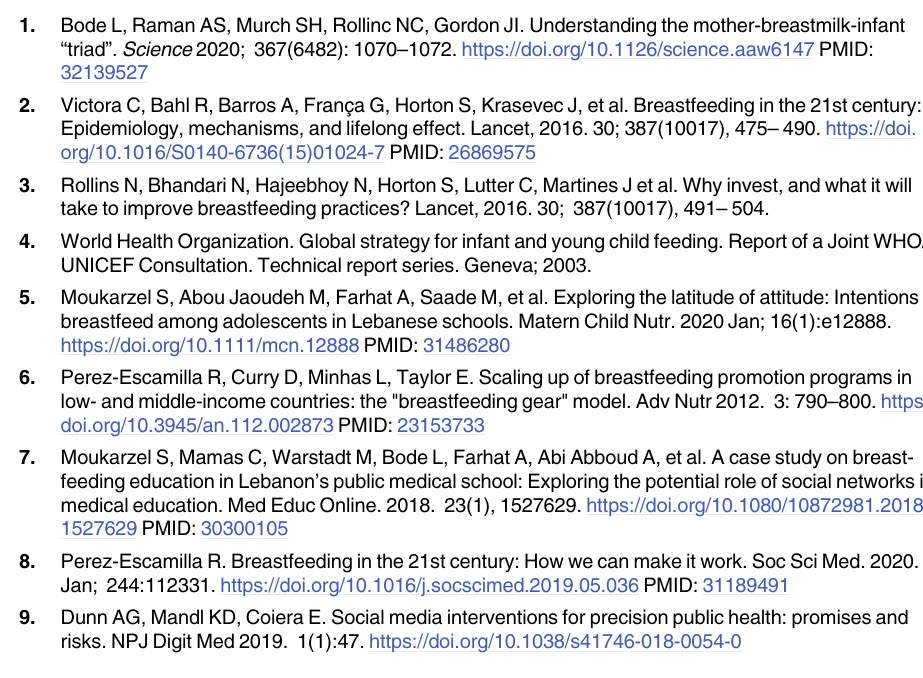
S1 Table. Description of identified key influencers. HCP, health care practitioner; NGO, non-governmental organization; BF, breastfeeding. n = 59 influencers. S1 Fig. Illustration of a one-step and two-step ego network map. One-step, describes an influencer’s (ego’s) immediate alters (users who retweet or mention the influencer) and the connections among these alters. Two-step, describes an influencer’s one-step network as well as the alters of the